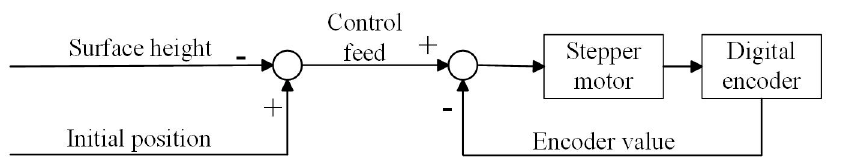
Figure 9. Schematic diagram of stepper motor control.